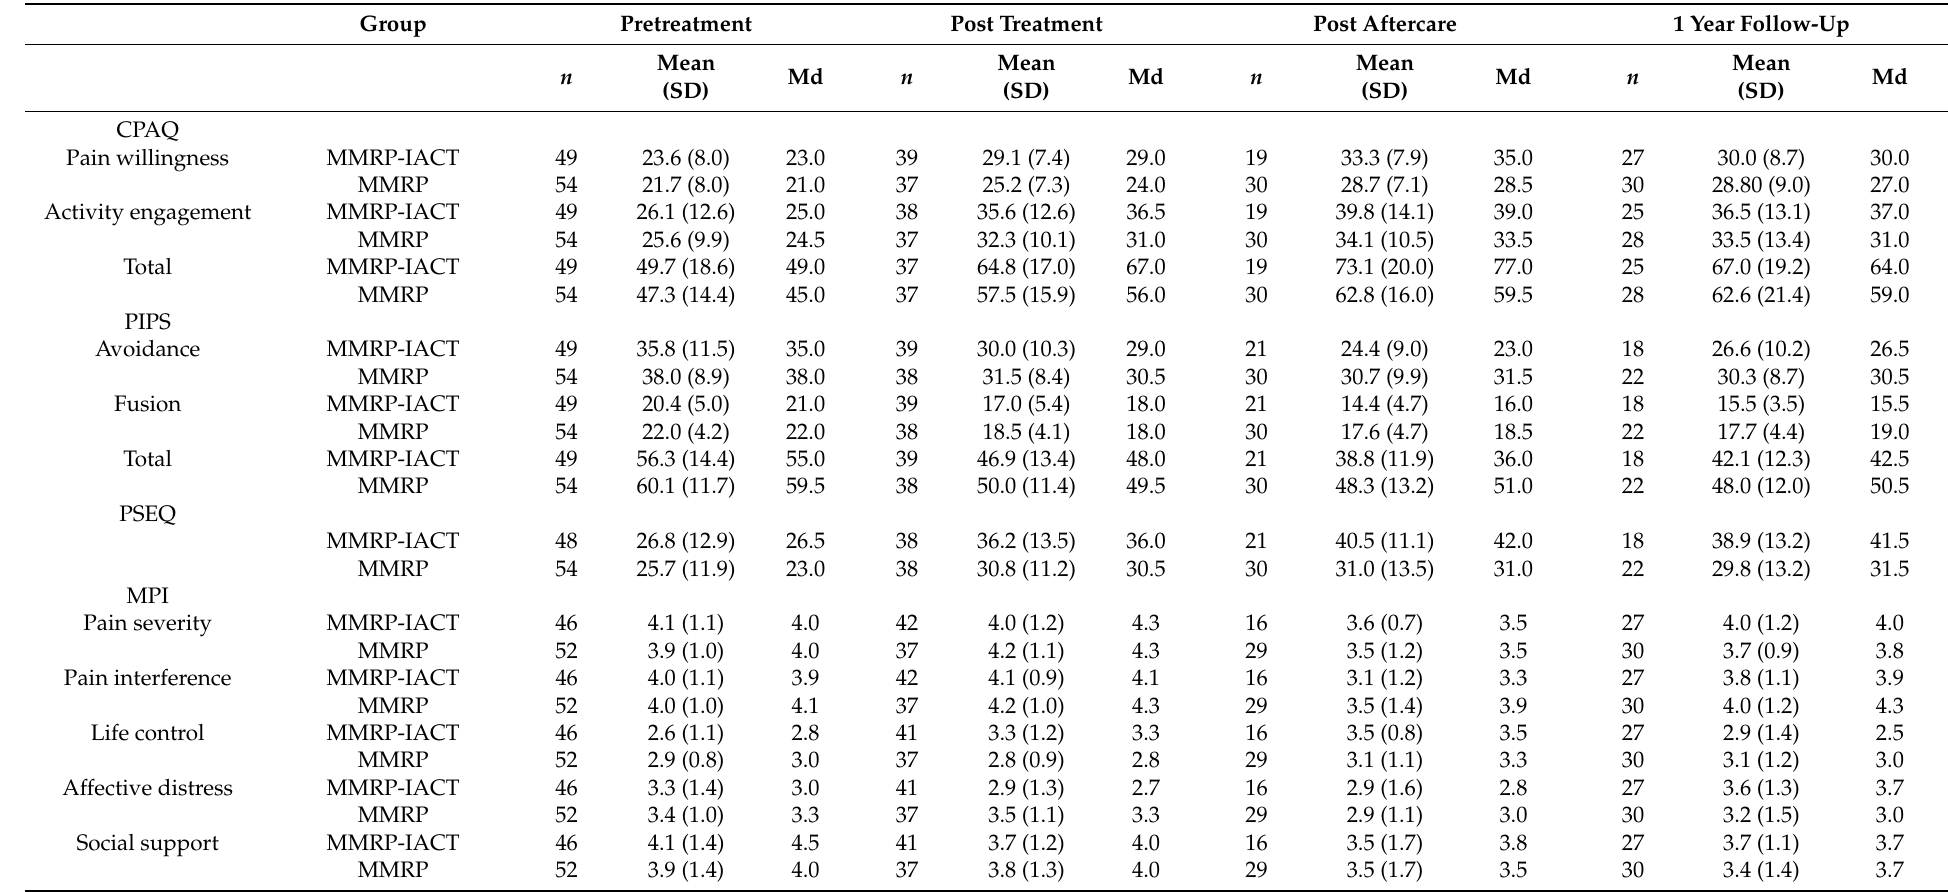
Table 2. Means (SD) and medians (Md) on outcome measures Chronic Pain Acceptance Questionnaire (CPAQ), Psychological Inflexibility in Pain Scale (PIPS), Pain Self-efficacy Questionnaire (PSEQ) and Multidimensional Pain Inventory (MPI), for MMRP-IACT and MMRP respectively at pretreatment, at post treatment, at post aftercare intervention and at 1 year follow